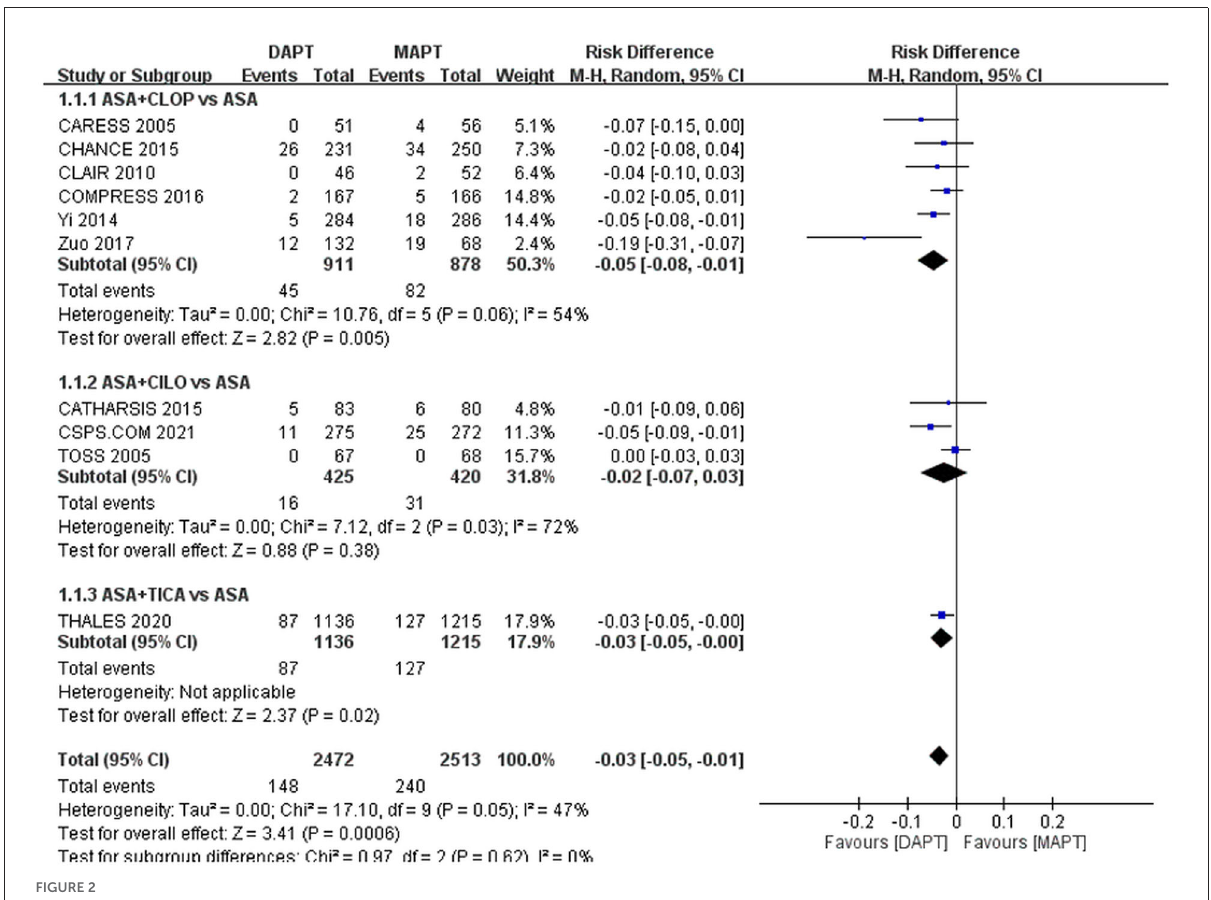
FIGURE2 Forest plot for outcome of ischemic stroke. Compared to MAPT, DAPT significantly reduced ischemic stroke recurrence in patients with symptomatic large artery atherosclerosis. ASA, aspirin; CILO, cilostazol; CLOP, clopidogrel; DAPT, dual antiplatelet therapy; MAPT, mono antiplatelet therapy, M-H, Mantel-Haenszel method; TICA,